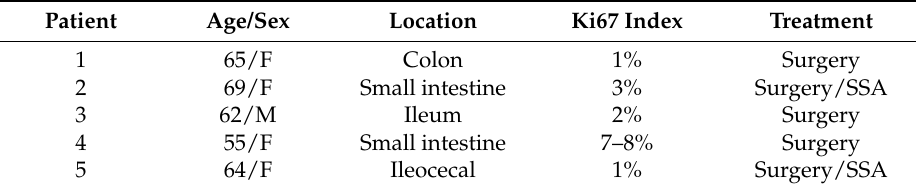
Table 1. Tissue used for immunohistochemistry, in situ hybridization and